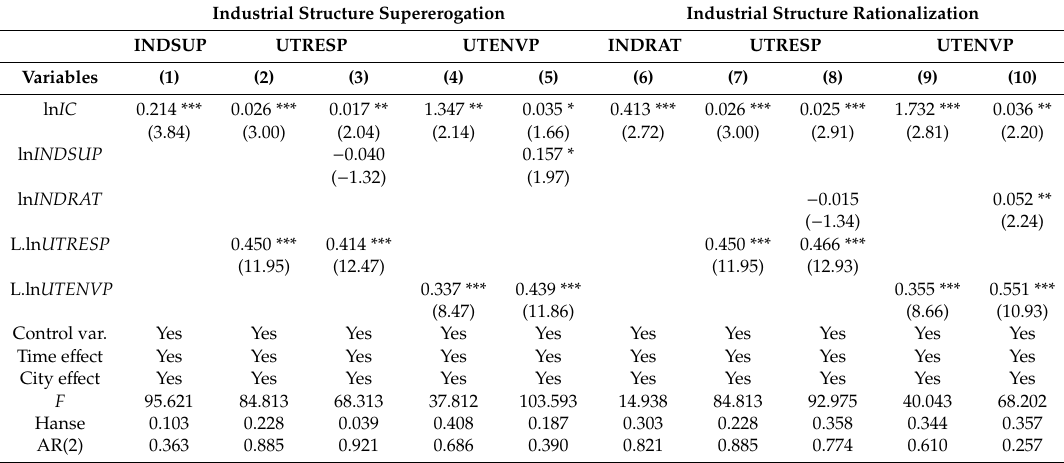
Table A3. Robust analysis of industrial structure restructuring e ff ect.